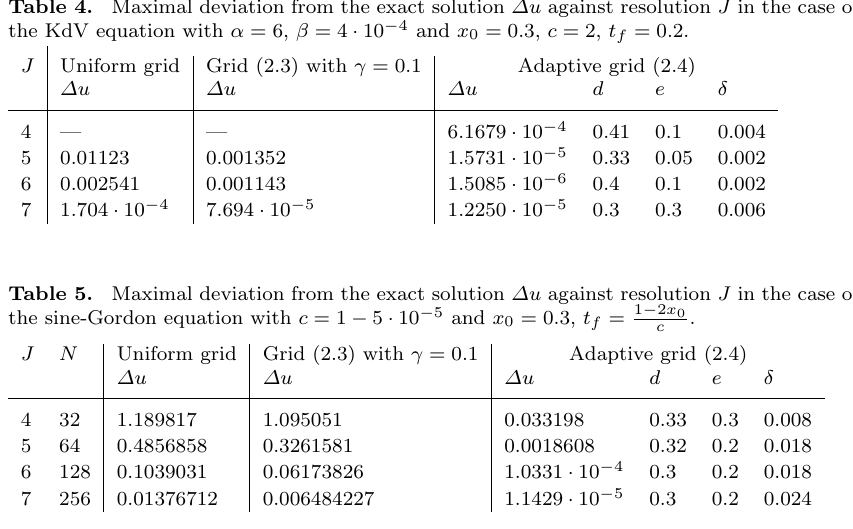
Table 4. Maximal deviation from the exact solution ∆u against resolution J in the case of the KdV equation with α = 6, β = 4 · 10 − 4 and x 0 = 0 . 3, c = 2, t f = 0 . 2. J Uniform grid Grid (2.3) with γ = 0 . 1 Adaptive grid (2.4) ∆u ∆u ∆u